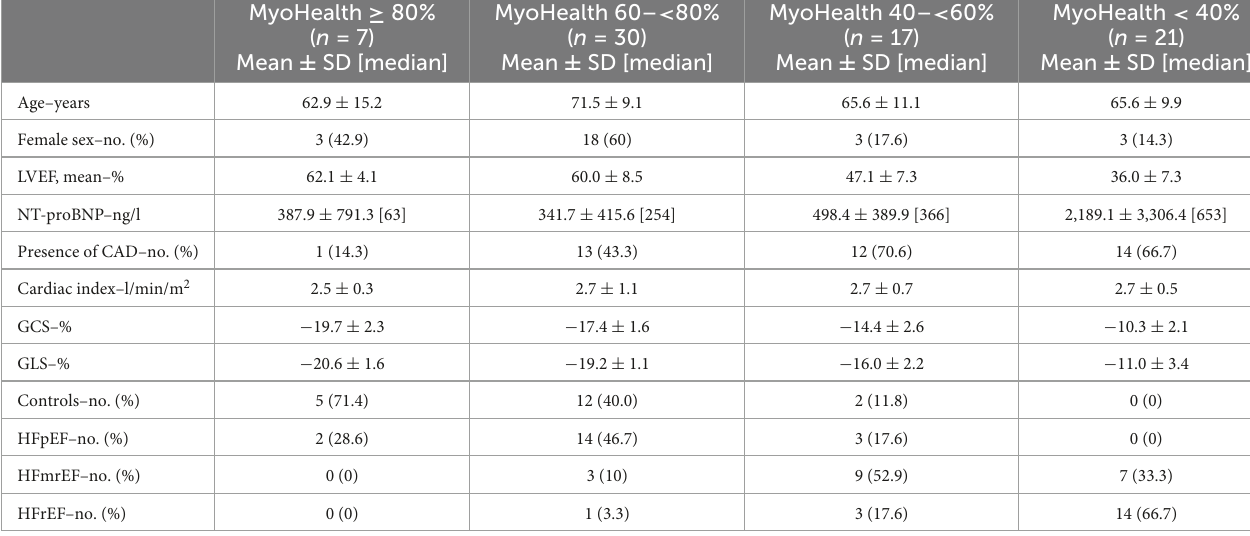
TABLE 2 Baseline characteristics by the ratio of non-altered LV segments (MyoHealth).